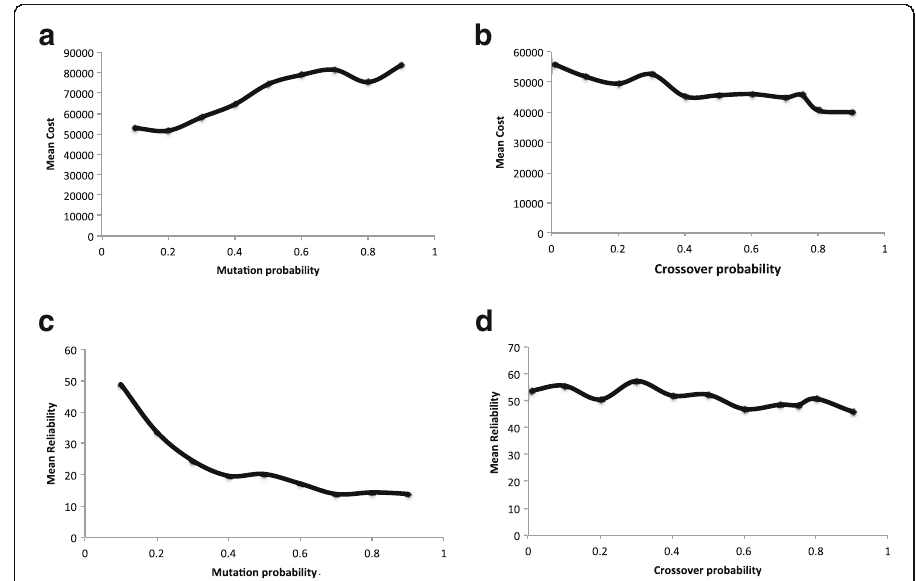
Fig. 4 Performance of NSGA2 with different crossover and mutation rates (on Problem 1). ( a ) Mean cost as a function of mutation probability. ( b ) Mean cost as a function of crossover probability. ( c ) Mean reliability as a function of mutation probability. ( d ) Mean reliability as a function of crossover